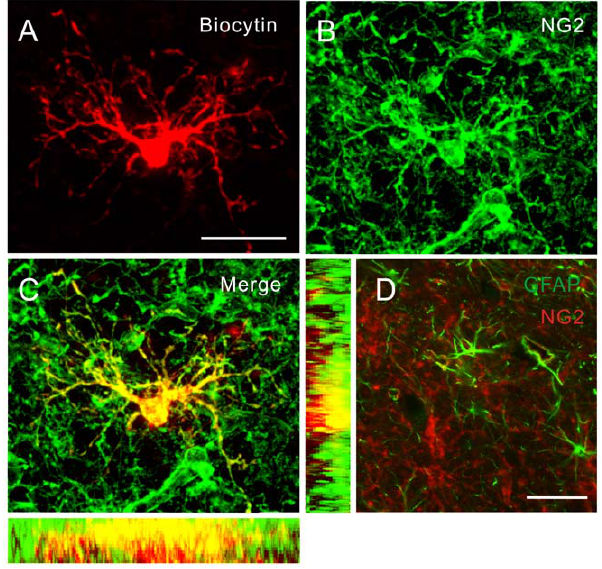
Figure 2. Post-hoc morphological and immunocytochemical analysis. (A) Two-photon image stack of a biocytin-filled NG2 cell stained with Alexa-594 conjugated streptavidin. Scale bar, 25 m m. (B) NG2 immunoreactivity of the same slice in (A). (C) Images of (A) and (B) are superimposed. Three orthogonal ( xy , xz and yz ) planes are shown. (D) Double immunofluorescent labeling of GFAP and NG2 proteins. Scale bar, 25 m m.